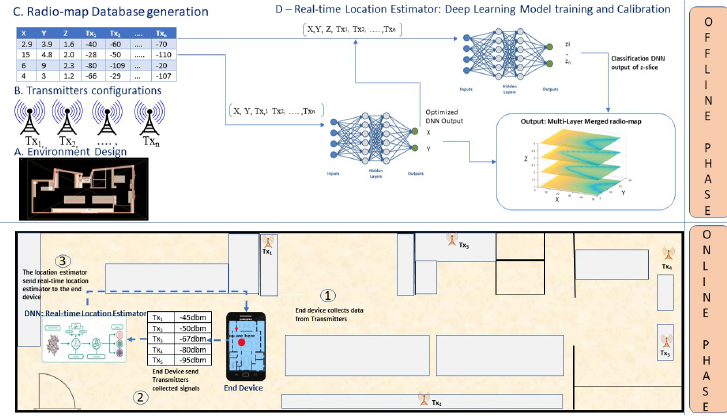
Figure 1. Detailed architecture of deep learning-based co-operative architecture